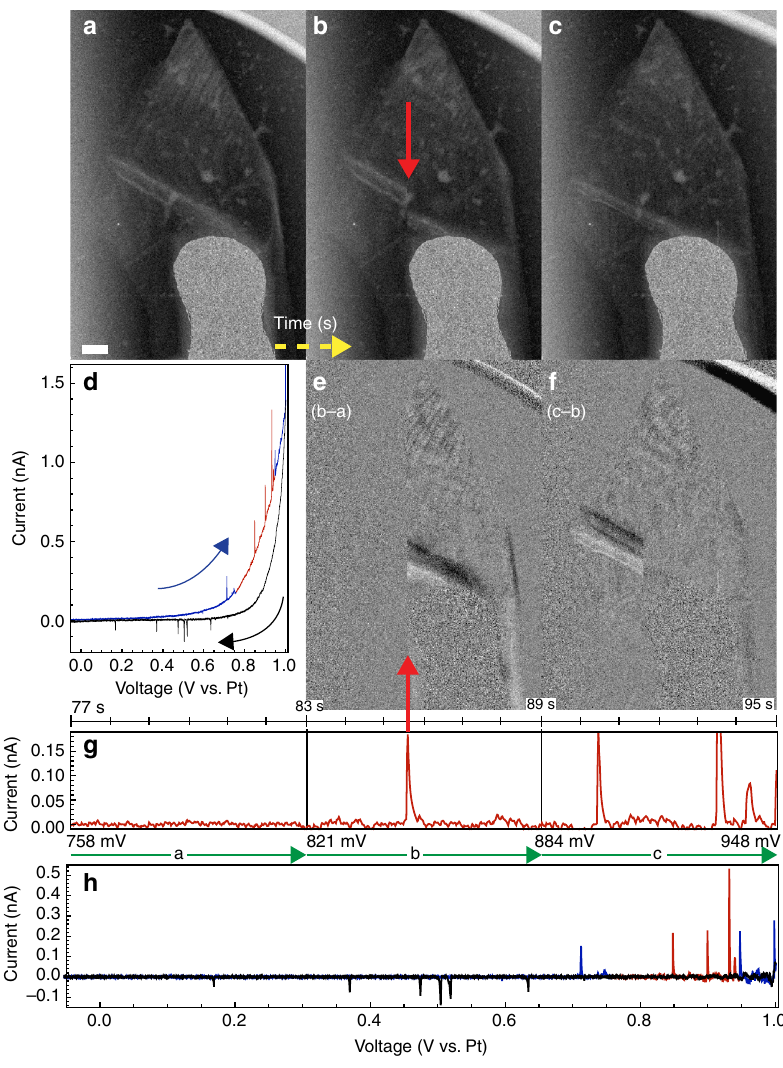
Fig. 2 Intercalation events. a – c Three sequential ADF STEM images of a single crystal graphite fl ake in a fl uid cell. (Supplementary Movie 2 is a more complete description of this experiment.) Here the images are oriented such that the beam raster proceeded bottom-to-top and then left-to-right. Structural changes in the graphite fl ake occurred during the acquisition of b at the time indicated by the red arrow. d Cyclic voltammogram obtained during this experiment. Arrows indicate the ramp direction of the voltage during intercalation (blue) and deintercalation (black). e , f Computed difference images: ( b – a and c – b ) highlight the changes between these sequential frames. g Voltage applied (constant ramp rate of ± 10 mV s − 1 ) and current (background- subtracted) measured during the acquisition of a – c , with the abscissa scaled to match the timing of a – c and e , f . An intercalation current peak (containing 28 pC, equivalent to 1.5 crystal-spanning intercalant layers) is coincident with the structural changes that occur during the acquisition of b . h The voltammogram for the complete cycle d , after background current subtraction. The scale bar is 500 96%), pre-patterned platinum electrodes and single-crystal graphite fl akes (typical crystallite size ~ 100 μ m 2 × 10 nm) produced via mechanical exfoliation from bulk natural graphite (Naturgraphit GmbH). Figure 1 shows a schematic of the STEM cell architecture